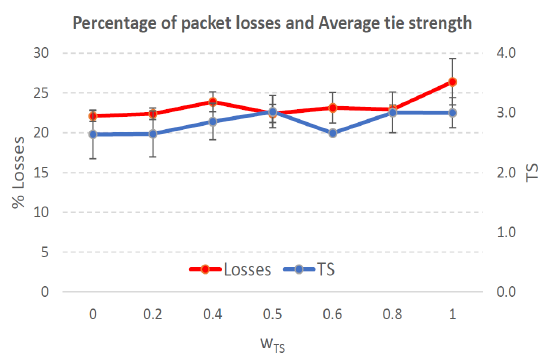
Figure 12. Percentage of packet losses and average tie strength of the forwarding path. Scenario with high social media interaction (TS normal distribution with µ = 3 and σ = 1). Nodes’ density = 100 nodes/km 2 .